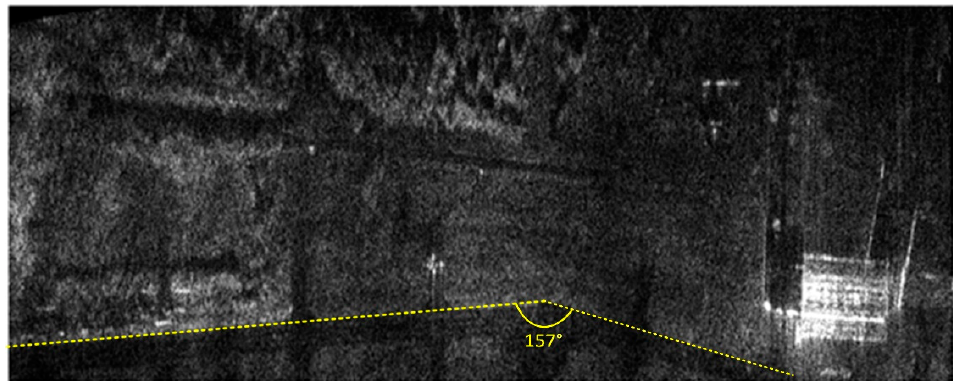
Figure 9. Radar terrain image obtained with the use of INS data; yellow line—a north edge of the taxiway determined using INS-based image.